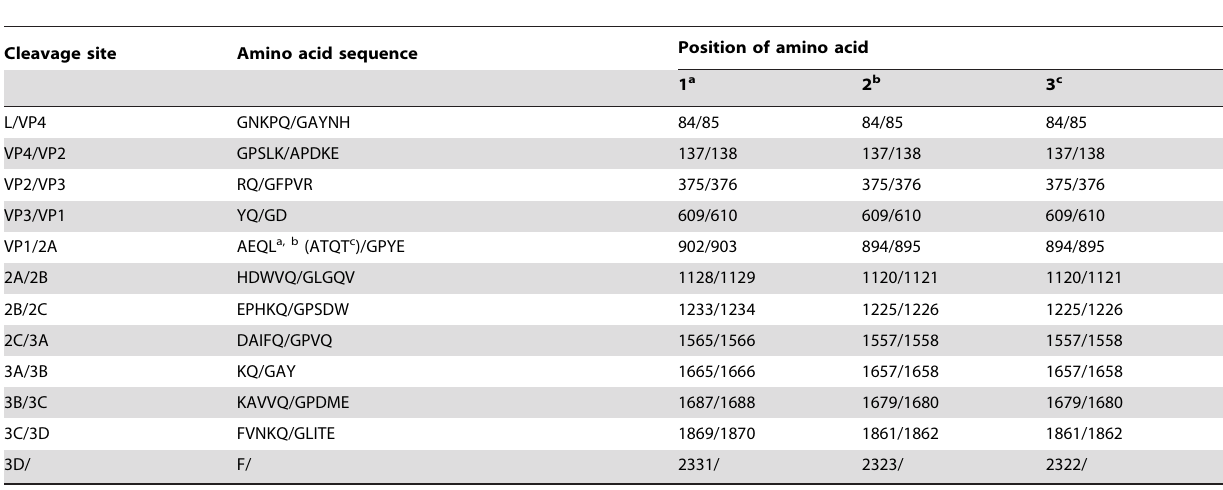
Table 1. Location of putative cleavage sites in the porcine sapelovirus polyprotein.